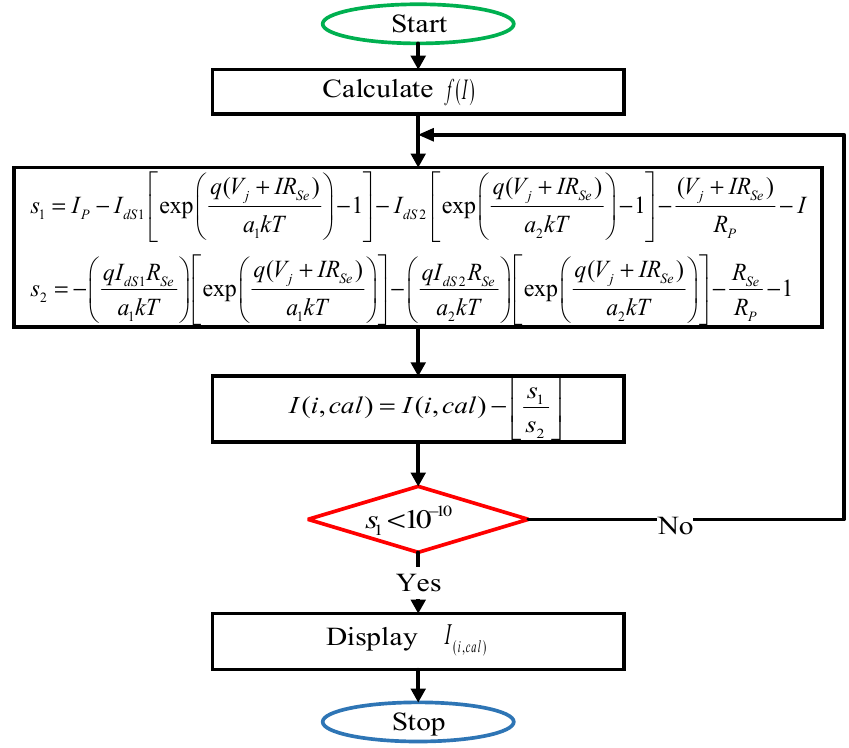
Figure 4. NRM flow chart of the double-diode model for the current calculations.